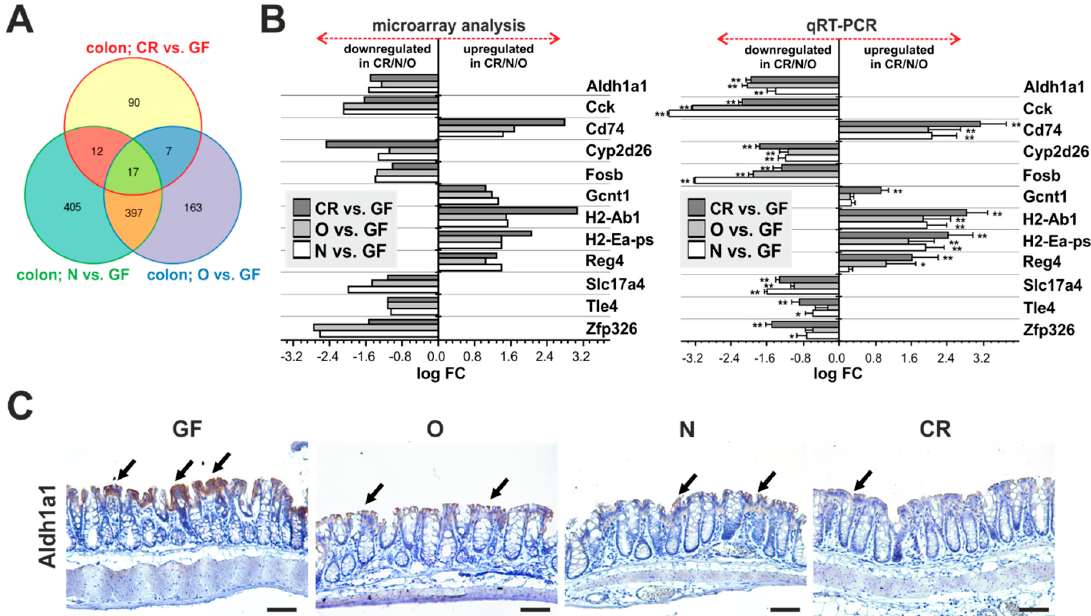
Figure 3. Aldh1a1 represents a robust marker of the GF colon. ( A ) A Venn diagram comparing gene expression profiles of the colonic mucosa of CR, N, and O animals when contrasted with the gene expression profile obtained in GF mice. According to the selection criterion (|log FC| ≥ 1; p < 0.05), 17 gene probes representing 12 annotated genes were identified. The genes are listed in Supplementary Table S3. ( B ) Validation of cDNA microarray by qRT-PCR. Comparison of expression analysis of the indicated genes performed by cDNA microarray hybridization (left) or by qRT-PCR (right). Samples obtained from four mice from each group were analyzed, as described in Figure 2B. Corresponding CT values are listed in Supplementary Table S4; * p < 0.05; ** p < 0.01 (one-way ANOVA test). ( C ) Immunohistochemical detection showing increased production of Aldh1a1 in differentiated epithelial cells (black arrows) of the colon of GF mice. Representative images of specimens counterstained with hematoxylin are shown. Scale bar: 0.15 mm.